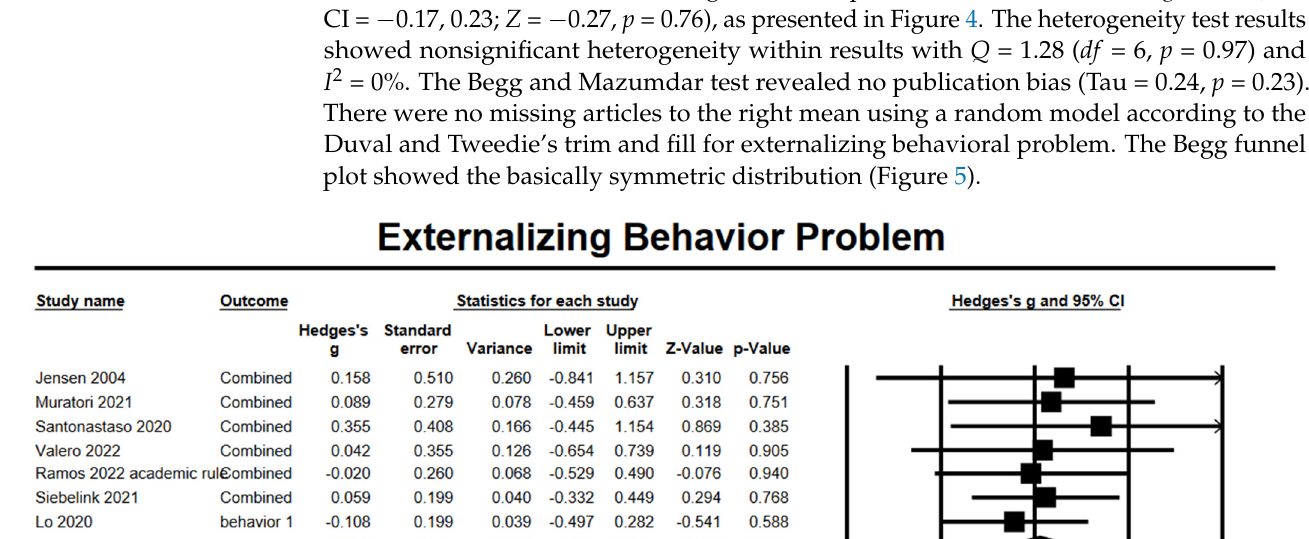
Table 3. Average effect sizes by types of outcome by times of measurement.